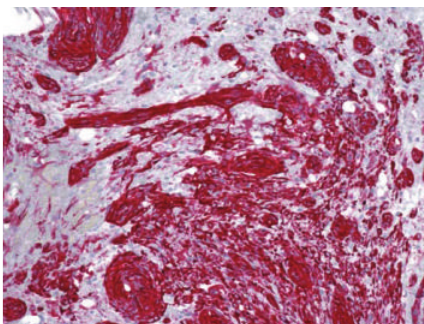
Figure 8: Perivascular wall tumor; right piriform lobe. The prolifer- ative tumor cells displayed a positive reaction for